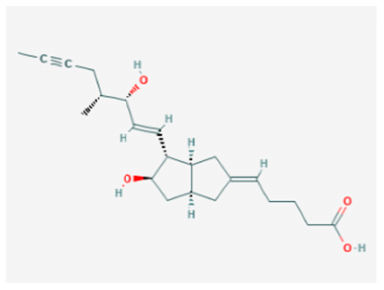
Figure 8. Interleukin-2 chemical